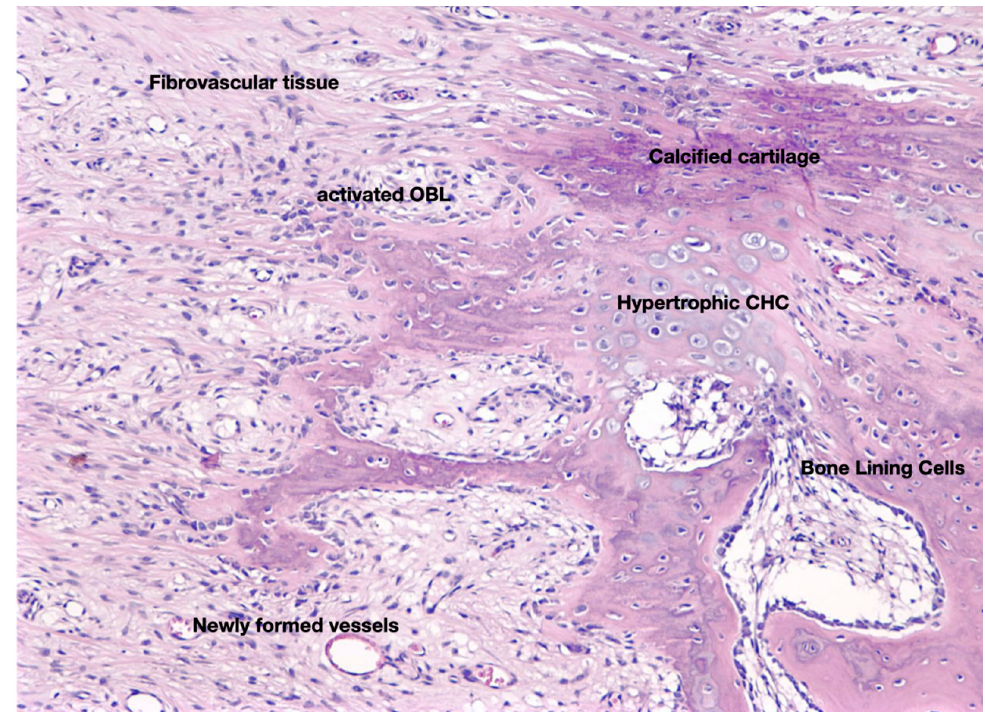
Figure 4. Histological section that depicts the cellular and molecular features of fibrocartilaginous callus which is formed during the anabolic phase of fracture-healing. Hypoxic conditions and mechanical stimulation determine whether SSC will follow the osteoblastic or the chondroblastic line of differentiation, giving genesis to bone and cartilage respectively, two cardinal elements of this phase of the fracture repair process. At the end of the anabolic phase the fractured bone parts are stabilized by hard (boney) callus (original magnification 5×).